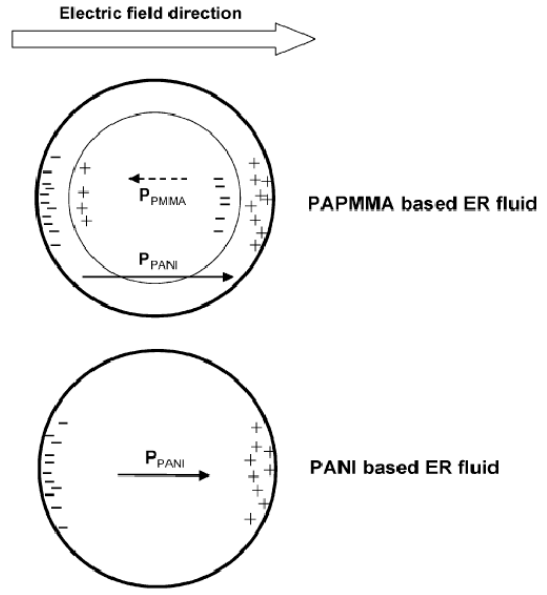
Scheme 10. Possible scheme of the polarization behavior for PMMA/PANI and PANI particles under an electric field. (Cho et al. [57], Copyright American Chemical Society, 2003).